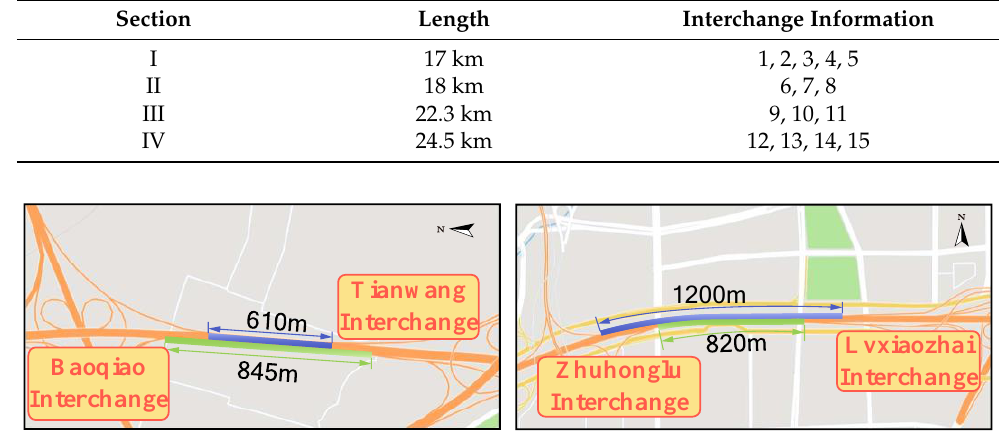
Figure 2. Schematic diagram of SSI.